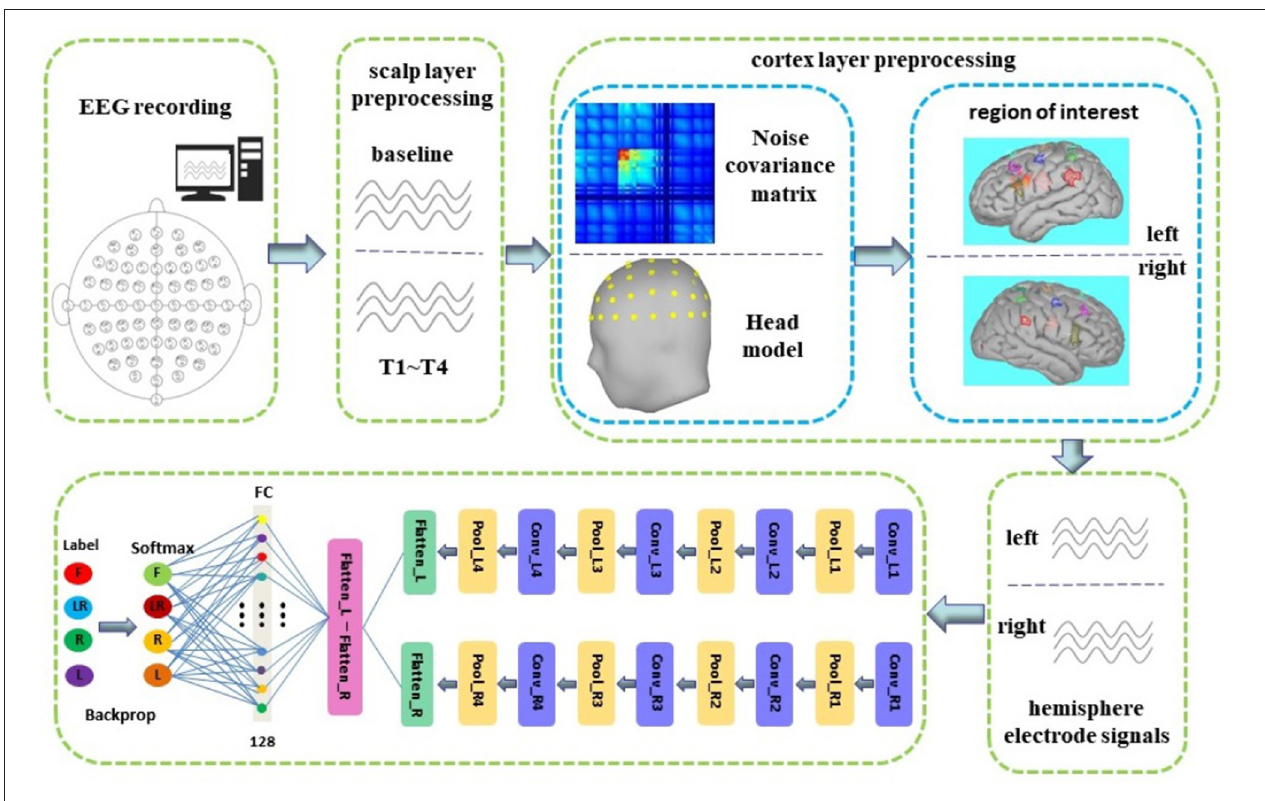
FIGURE 1 | The framework of the proposed